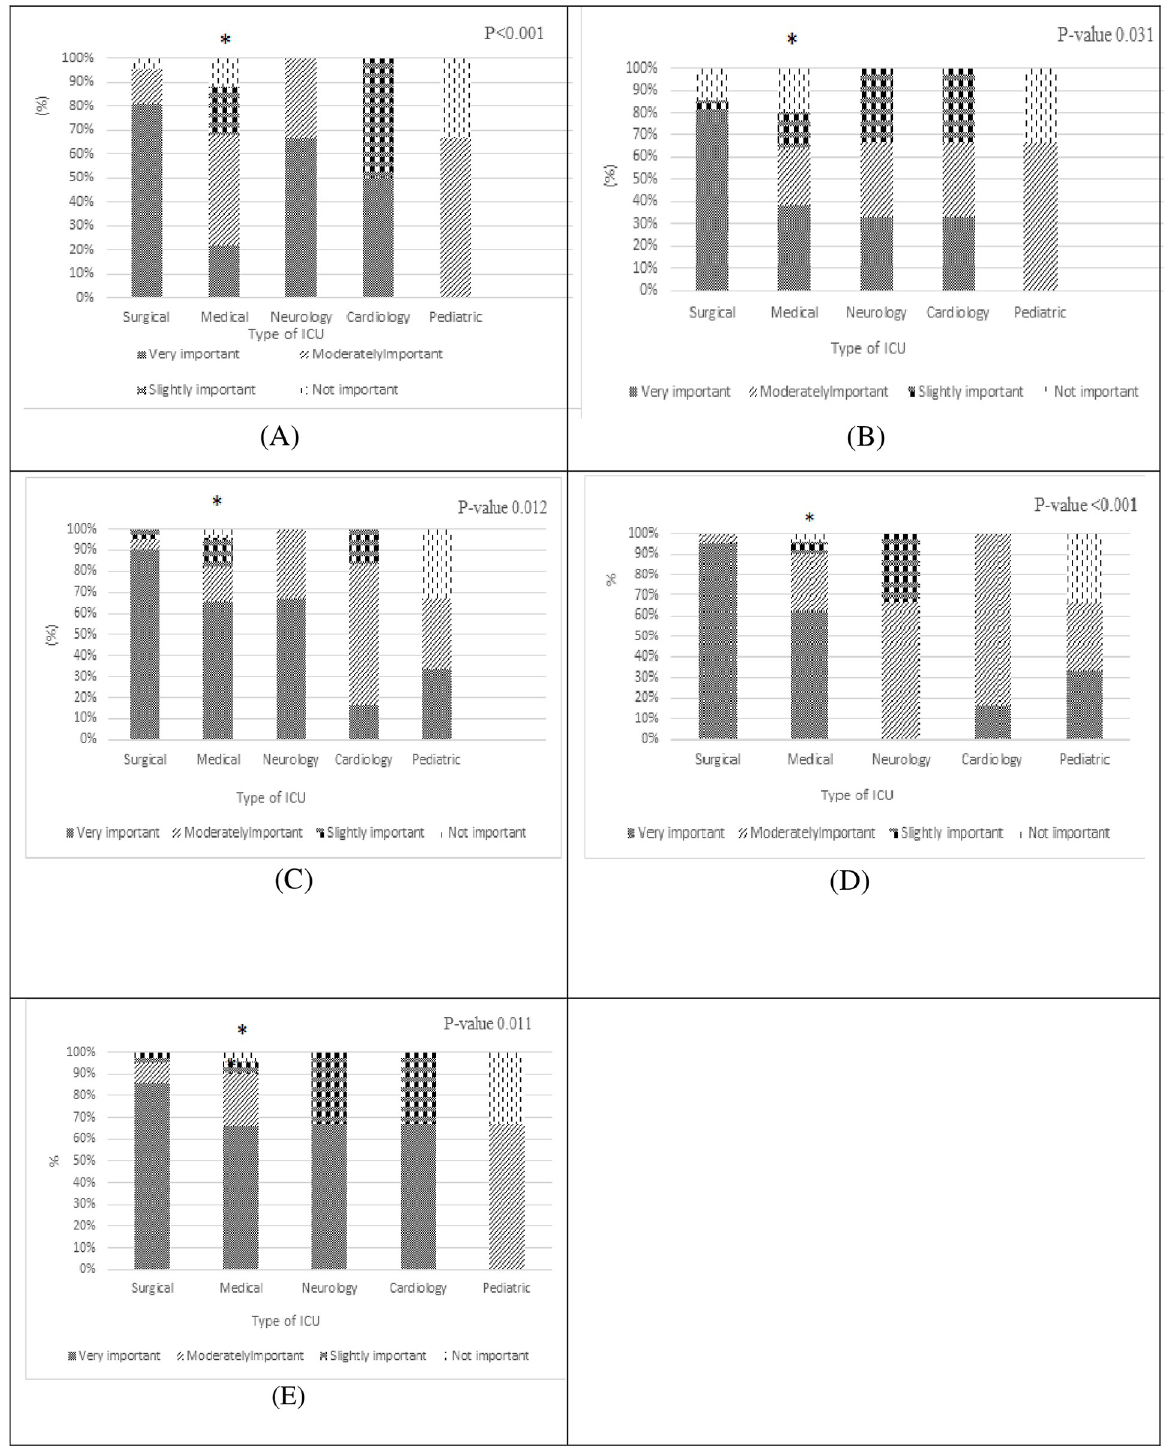
Fig 2. Relationship between physician’s perceptions regarding causes of AMR and type of ICU ( � significant p -value < 0.05 compared to other types of ICUs (Surgical, Neurology, Cardiology, Pediatric)). (A) shows perception of physicians regarding using broader than necessary spectrum. (B) shows perception of physicians regarding the cause (shorter than standard duration). (C) shows perception of physicians regarding the cause (poor hand hygiene). (D) shows perception of physicians regarding the cause (poor infection control). (E) Perception of physicians regarding the cause (wrong practices in management of invasive